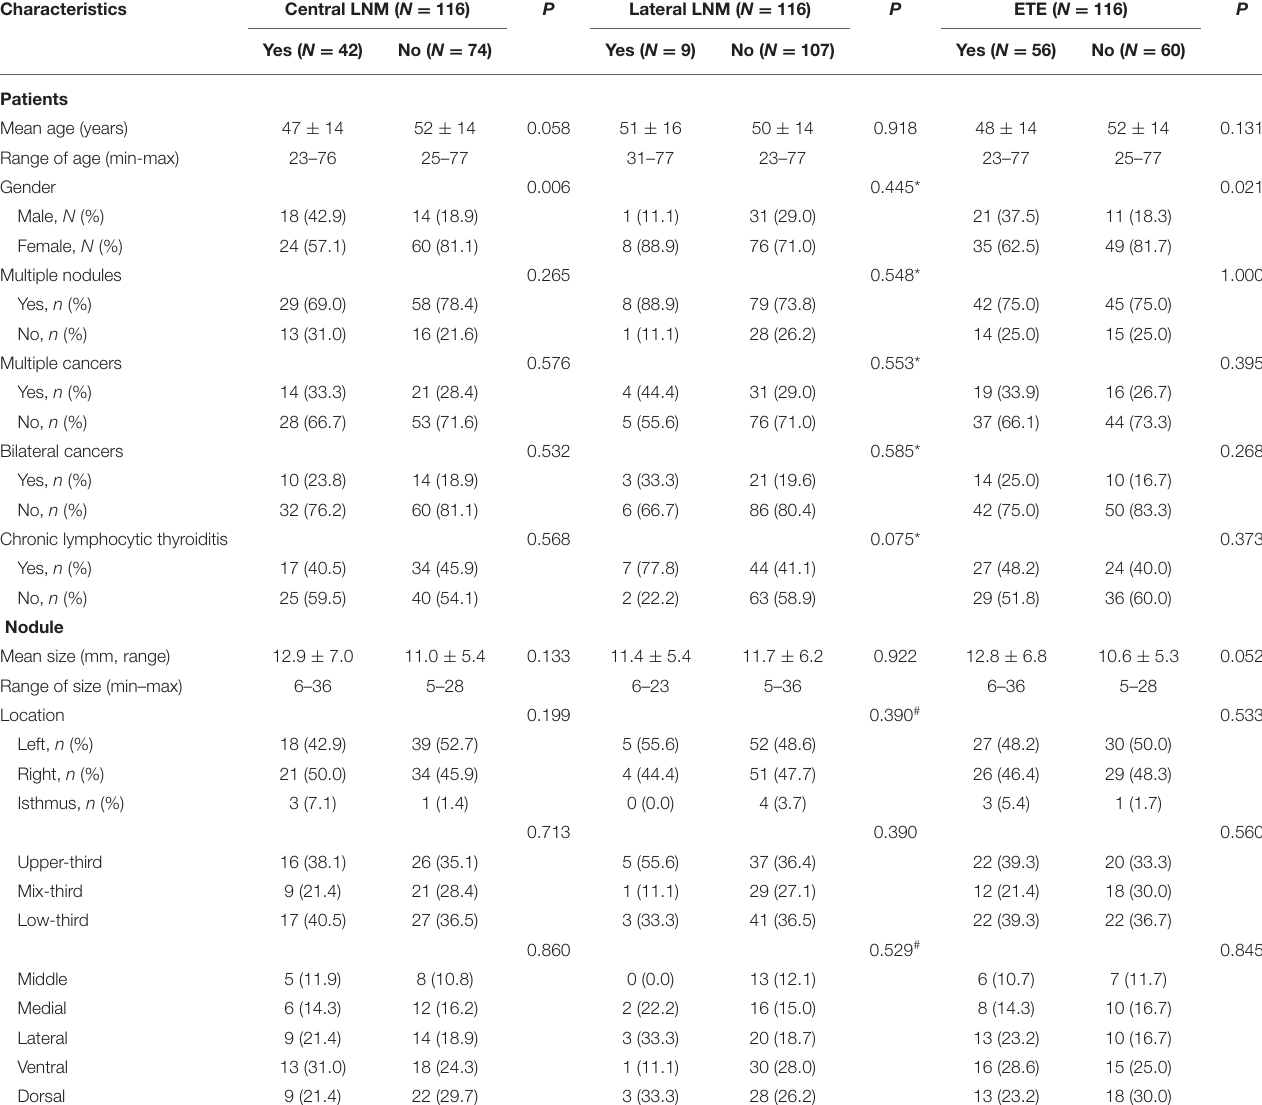
TABLE 1 | Basic characteristics of the patients with papillary thyroid cancer.